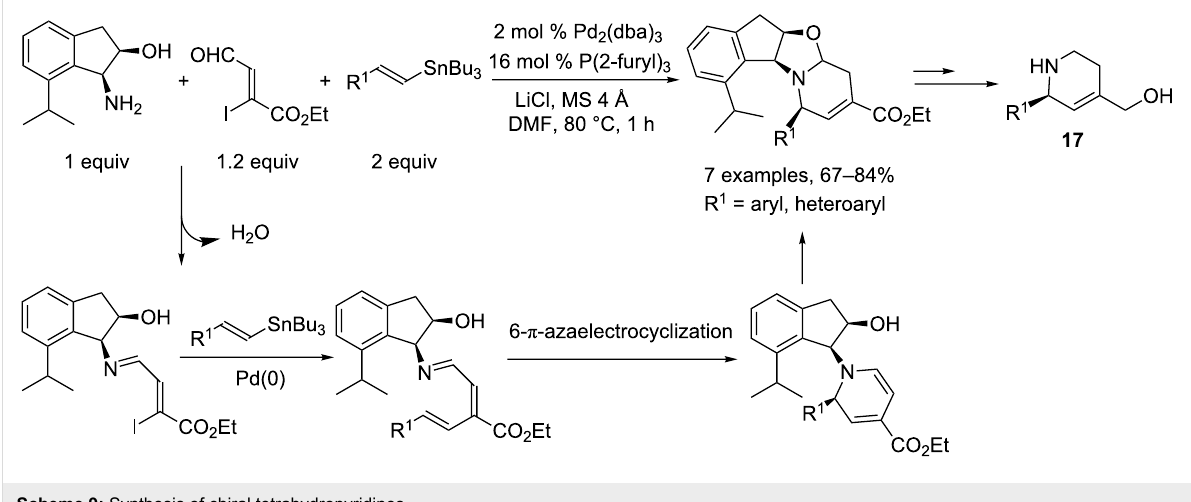
Scheme 9: Synthesis of chiral tetrahydropyridines.